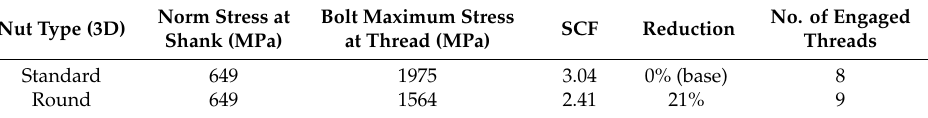
Figure 10. Finite element model (two-dimensional (2D) and 3D model). Table 5. Analysis results from 3D finite element (FE) model.